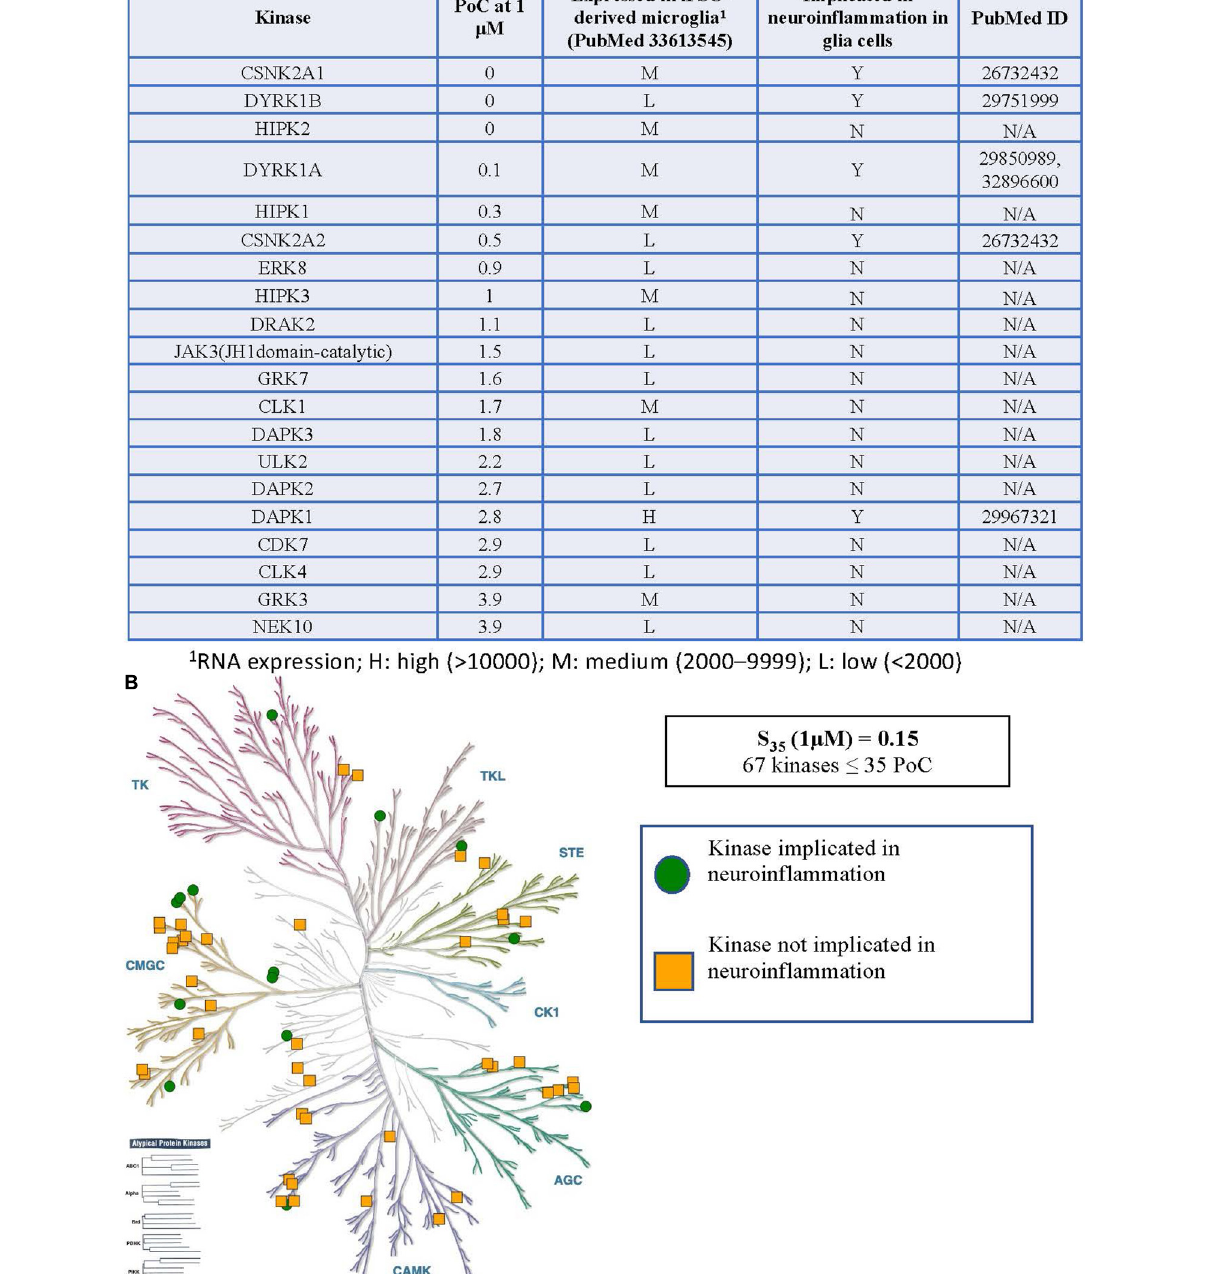
microglia-like cells that were generated in monoculture